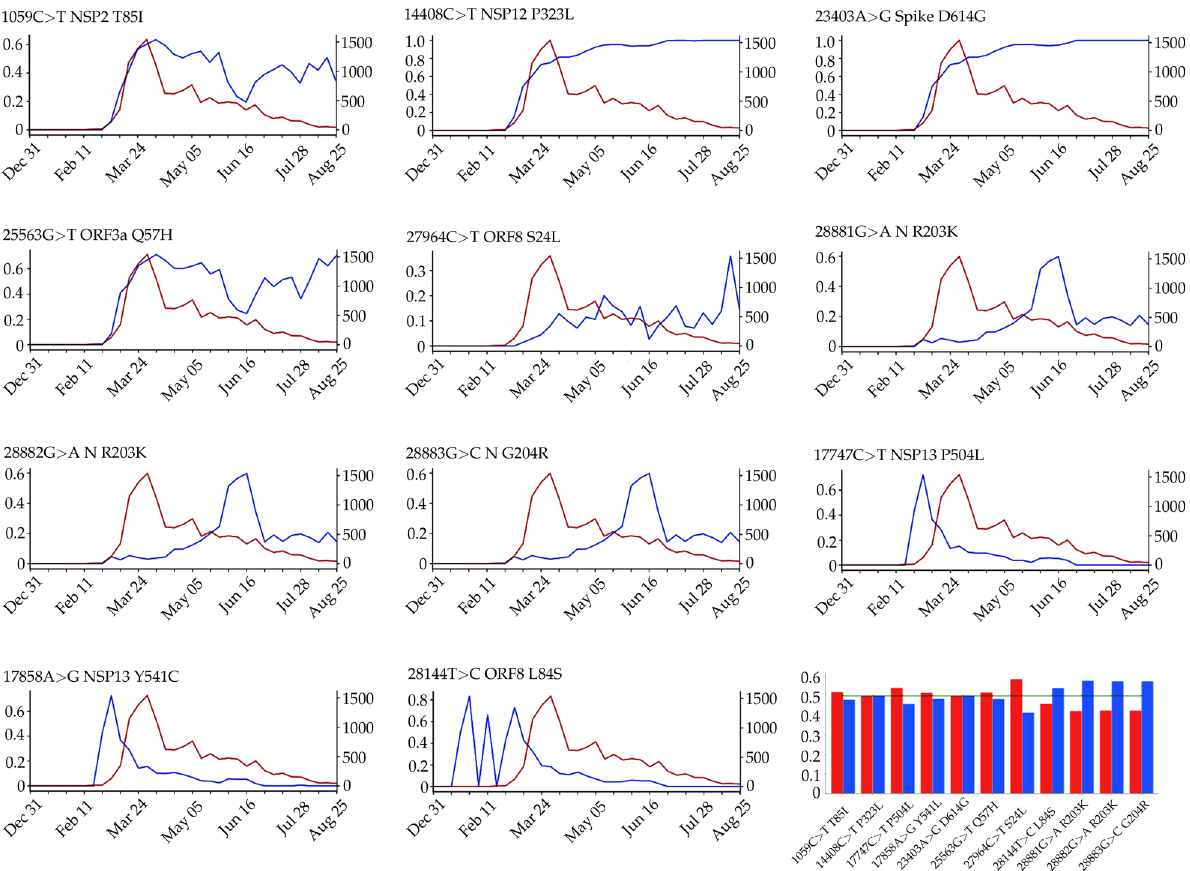
Fig. 2 The evolution and the gender distribution of the top 11 missense mutation ratios. The blue lines illustrate the evolution of the top 11 missense mutation ratios (the y -axis on the left) computed as the number of genome sequences having a given mutation over the total number of genome sequences. The red lines represent the evolution of the total number of genome sequences (the y -axis on the right). The bar plot is the gender distribution of the ratio of the number of samples having top 11 missense mutations over the total number of samples having age and/or gender labels. Red bars represent the female ratios and the blue bars represent the male ratios in the United